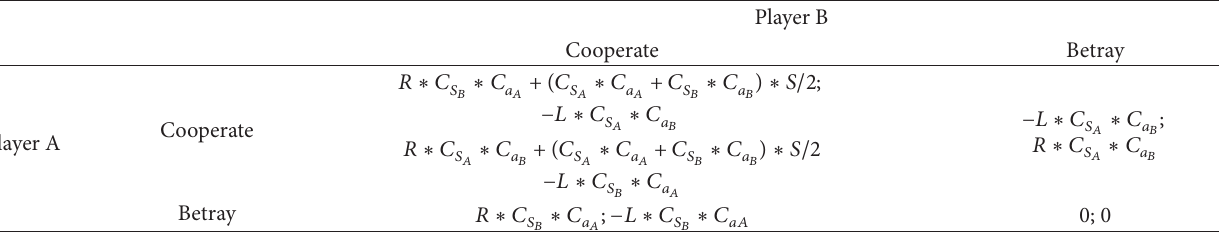
Table 2: The payoff matrix with the different firms’